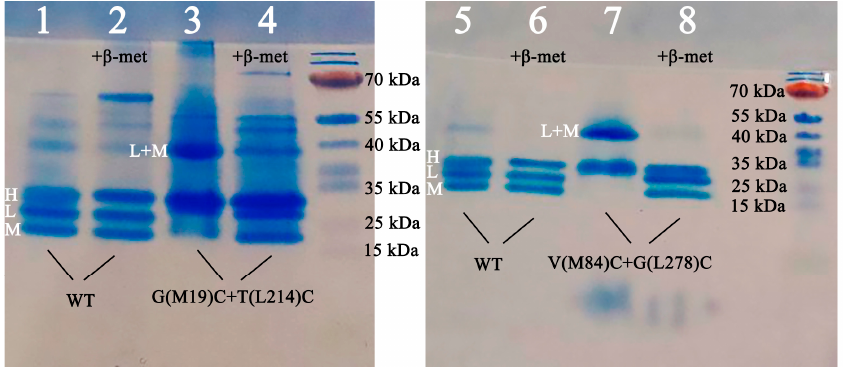
Figure 3. Tris/MES SDS PAGE of G( М 19)C+T(L214)C and V(M84)C+G(L278)C intra-subunit disulfide mutant reaction centers. β -Mercaptoethanol ( β -met) was added to the samples in lines 2, 4, 6, and 8.